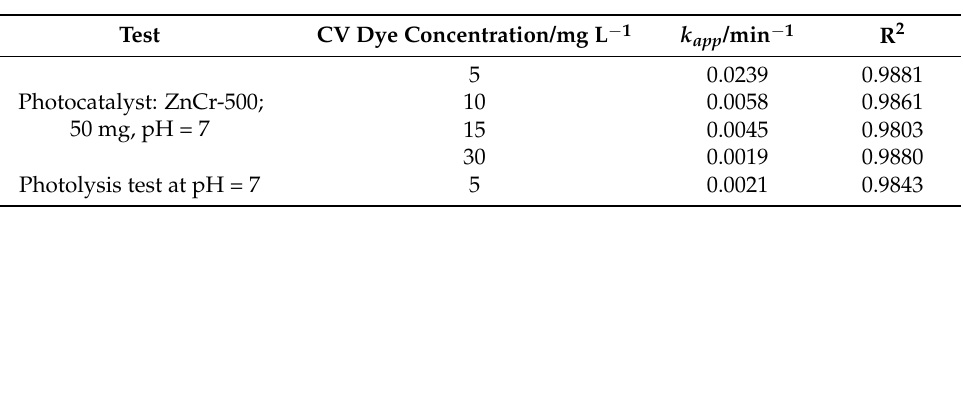
Table 2. Rate degradation constant for the tests using different CV dye